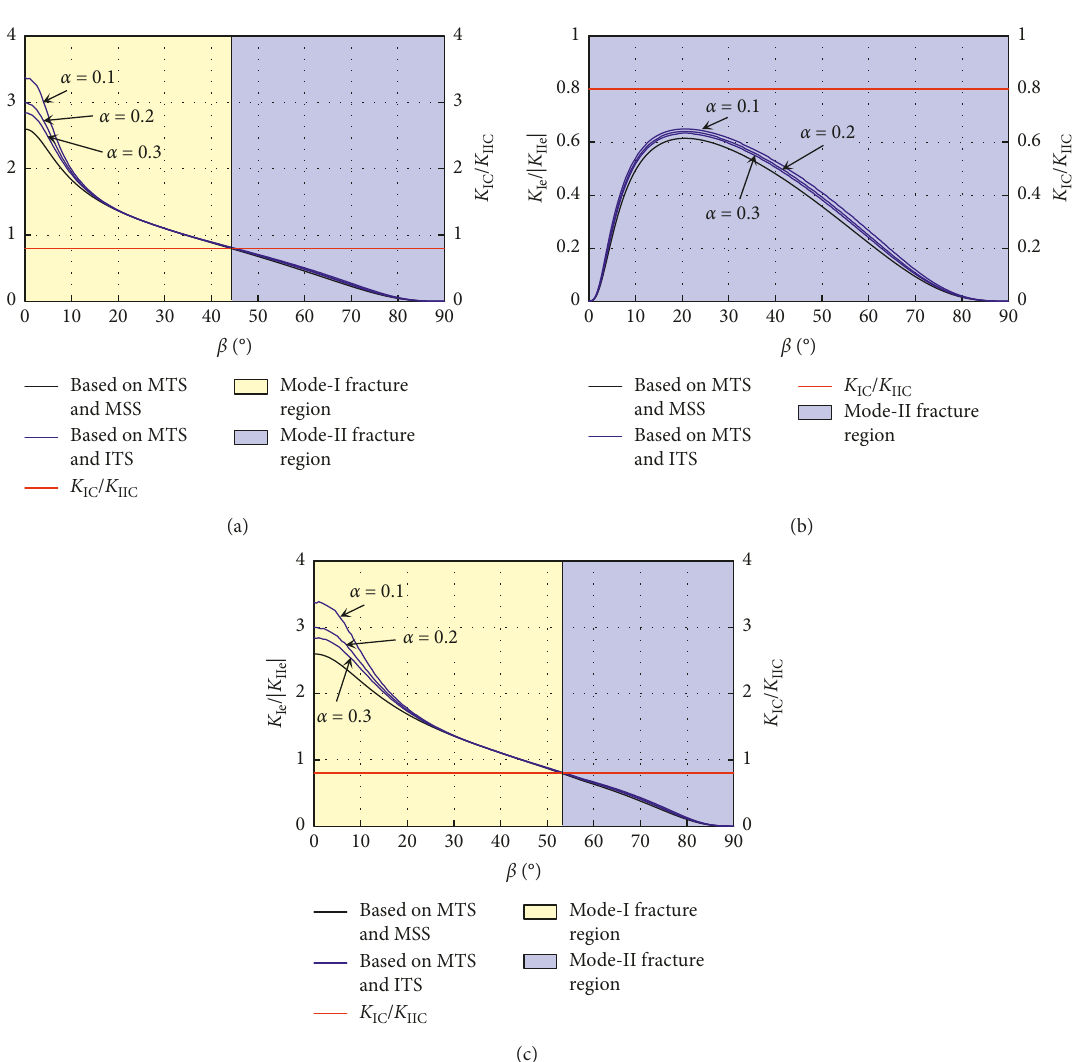
k � 0; (b) σ ∞ k � 0 . 4; (c) σ ∞ k � − 0 . y < 0, y < 0, y < 0,